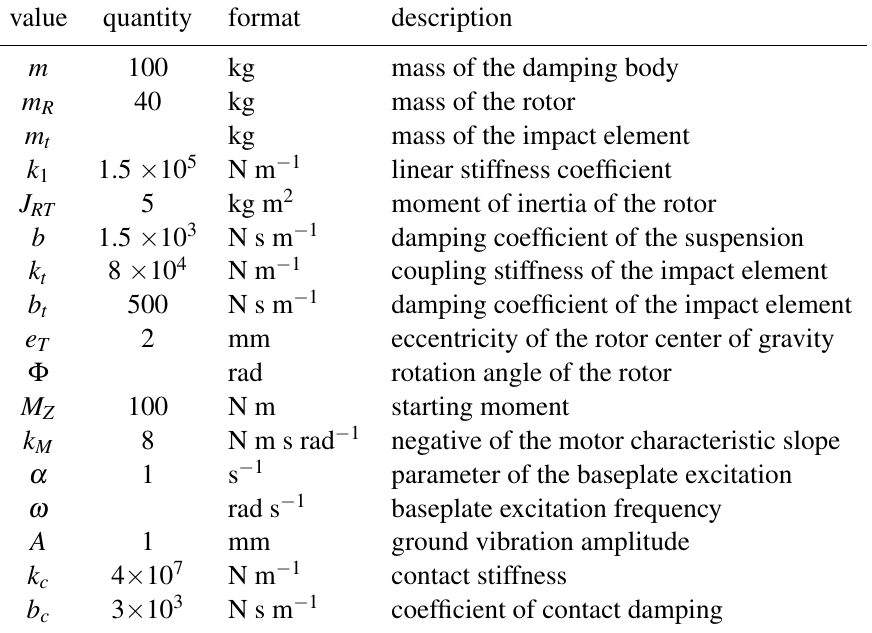
Table 1 Parameters of the system